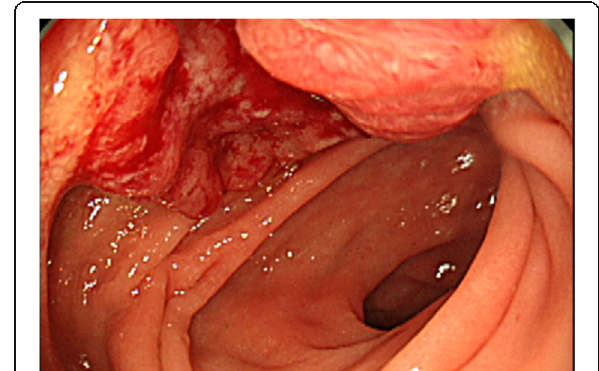
Fig. 1 Colonoscopy image of a rectal carcinoma. The rectal carcinoma easily bled, with an ulcer around an irregular mass 10 cm from the anal verge. Biopsy revealed this was a well- to moderately differentiated carcinoma